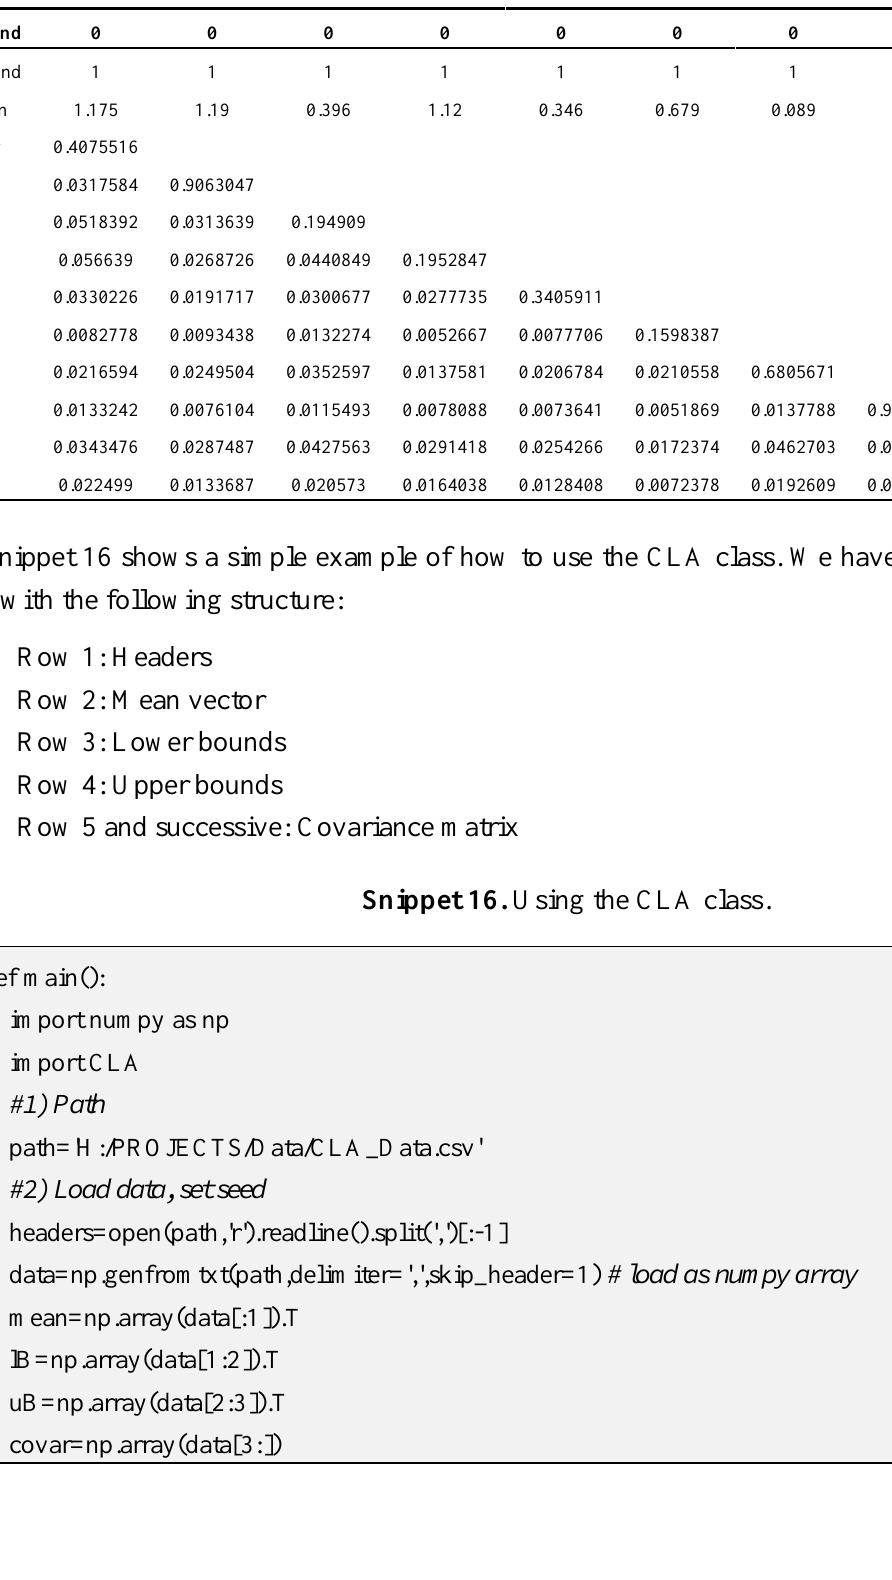
Table 1. Covariance Matrix, Vector of Expected Returns and boundary